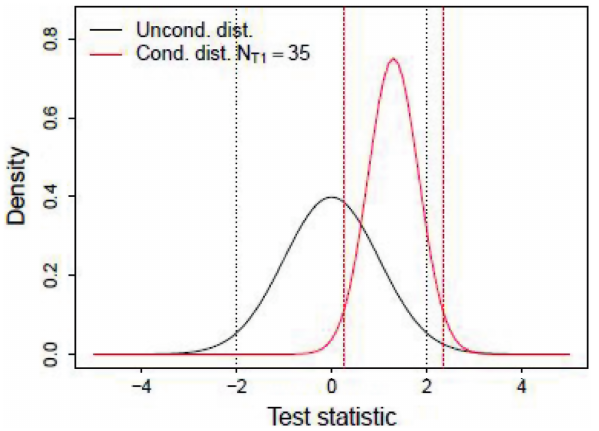
Figure 1: Unconditional and conditional distributions of test